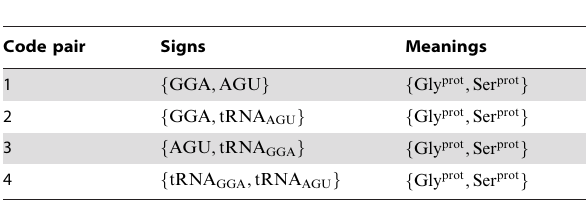
Table 3. Code pairs in the gene translation model.